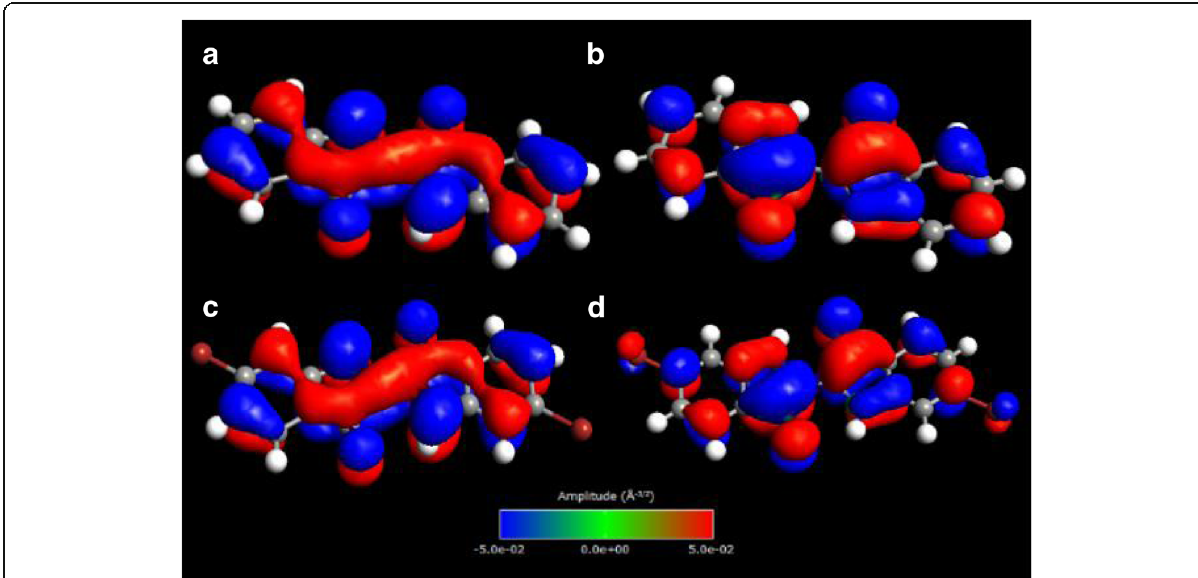
Fig. 2 Isosurface plots of HOMO-LUMO eigenstates for indigo ( a , b ) and Tyrian purple ( c , d ) molecules. The molecular geometries were obtained by relaxing the molecules in the neutral state